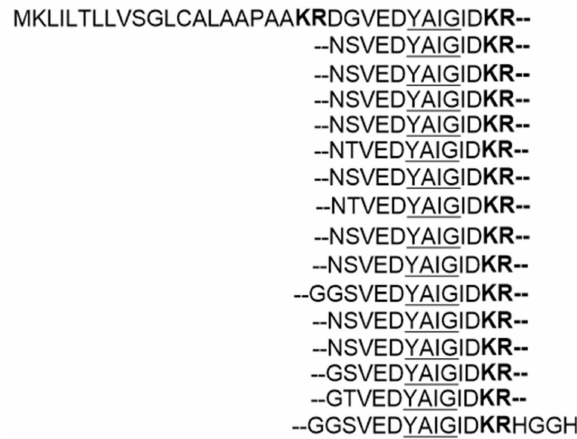
Figure 8. Sequence of UstA from Aspergillus flavus . KR motifs to be recognized by Kex2 protease are marked in bold. Repeated YAIG core sequences are underlined. Adapted from Reference